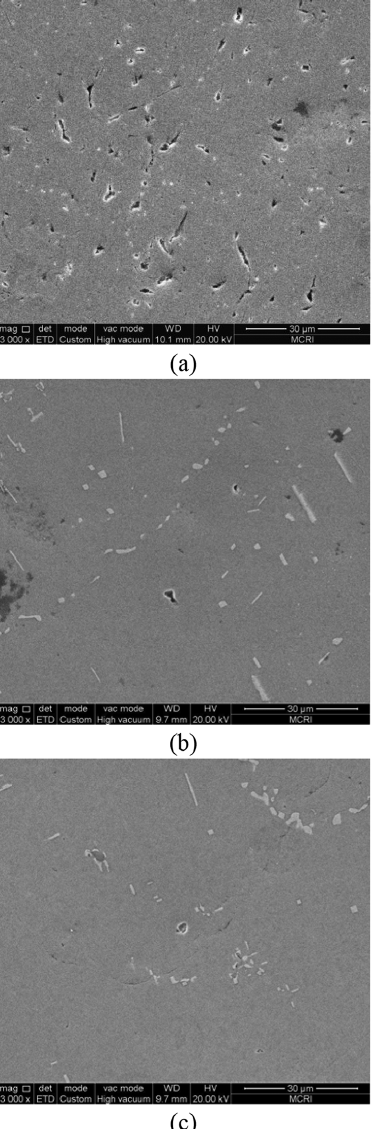
Figure 1: Casting defects in non-HIPed and HIPed K403 superalloy (not etched): (a) Cas; (b) H35 and (c)